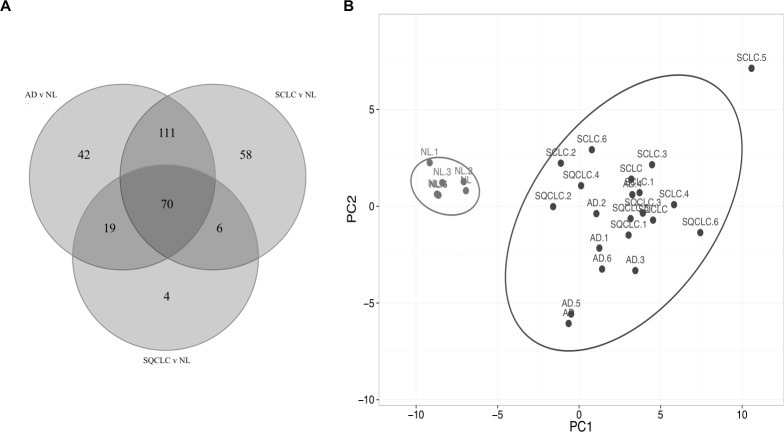
Cluster of normal lung tissue from lung cancer samples demonstrates separation power of using 70 HKGs.The numeric labels indicate the number of genes used to differentiate normal lung versus cancers shown in Fig. 1. (A) There are 70 HKGs with significant differential expression patterns common to AD, SCLC and SQCLC. (B) These 70 HKGs alone were able to achieve separation in an independent test set of six randomly selected normal lung tissues from AD, SCLC and SQCLC. NL, Normal Lung; AD, Adenocarcinoma, SCLC, Small Cell Carcinoma; SQCLC, Squamous Cell Carcinoma.